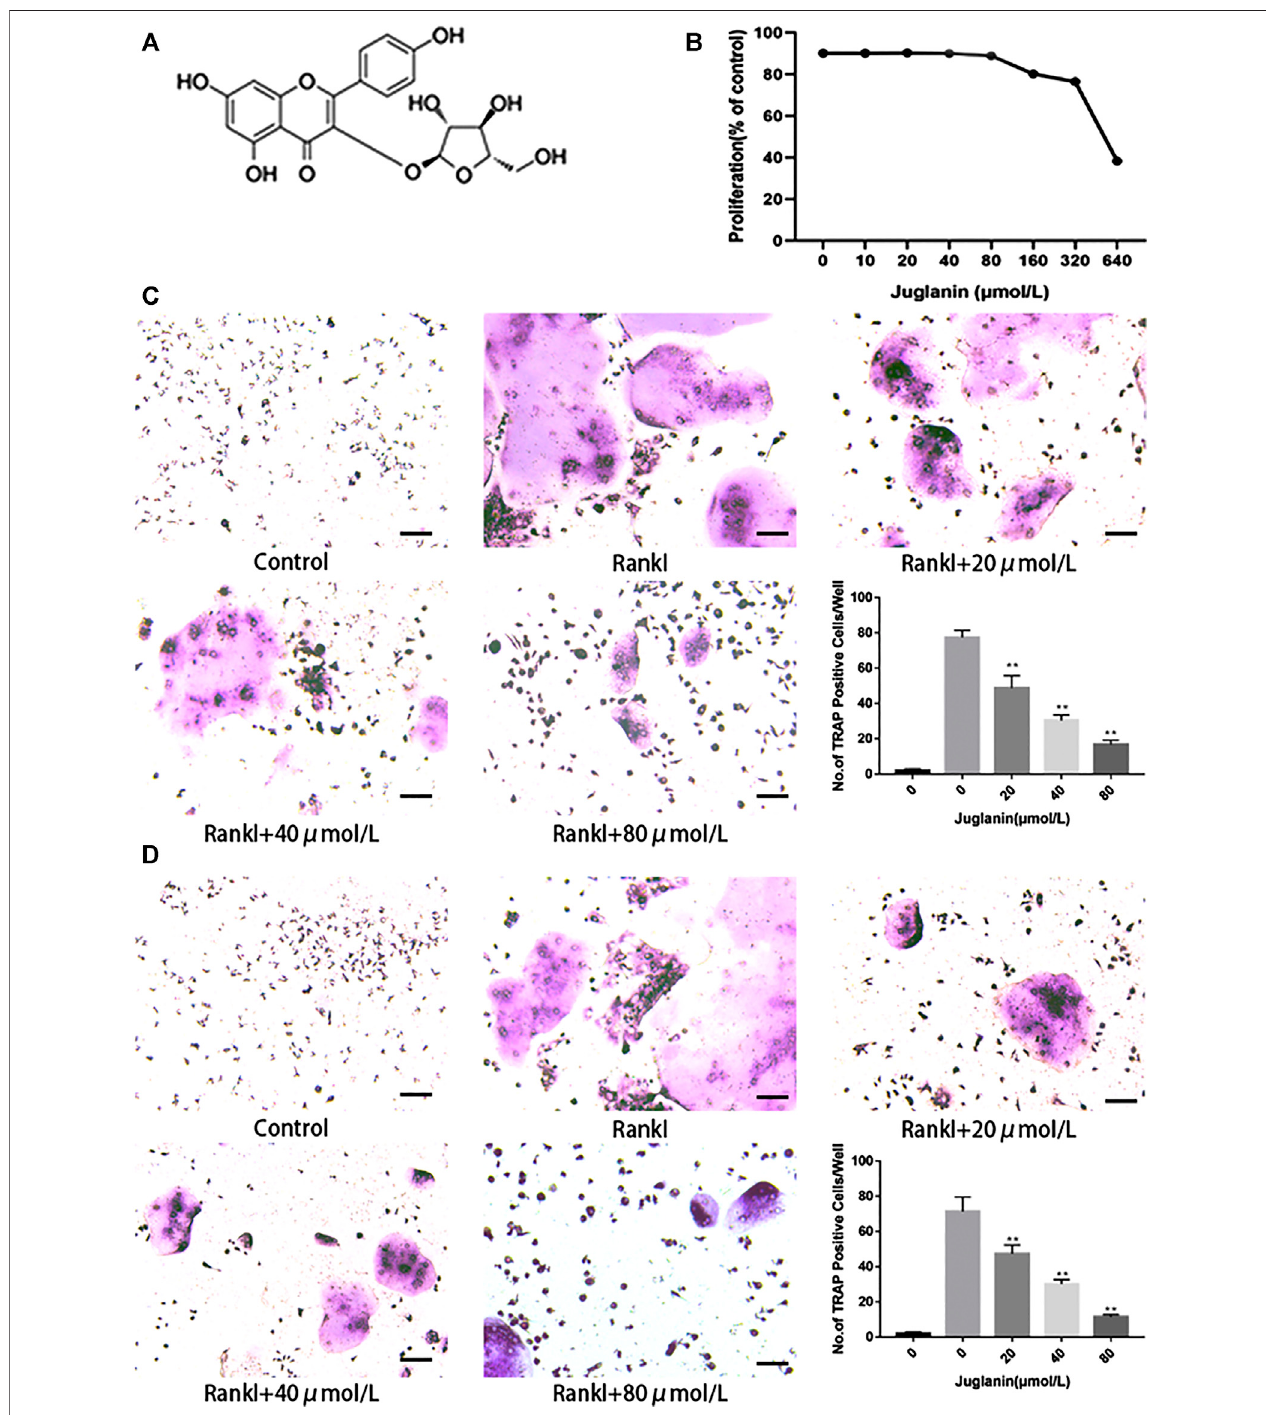
FIGURE 1 | JUG inhibits osteoclastogenesis in vitro . All the experiments were performed six times and the average was taken. (A) Chemical structure of JUG (B) MTT analysis ofJUG cytotoxicity in BMSCs. (C) Formation ofTRAP-positive cells from BMMs and quanti fi cation ofosteoclast (D) Formation of TRAP-positive cells from RAW264.7 cells and quanti fi cation of osteoclast. Scale bar 100 μ m. Data are presented as the mean ± SEM, * p < 0.05, ** p < 0.01 relative to the control group. n (cid:2)